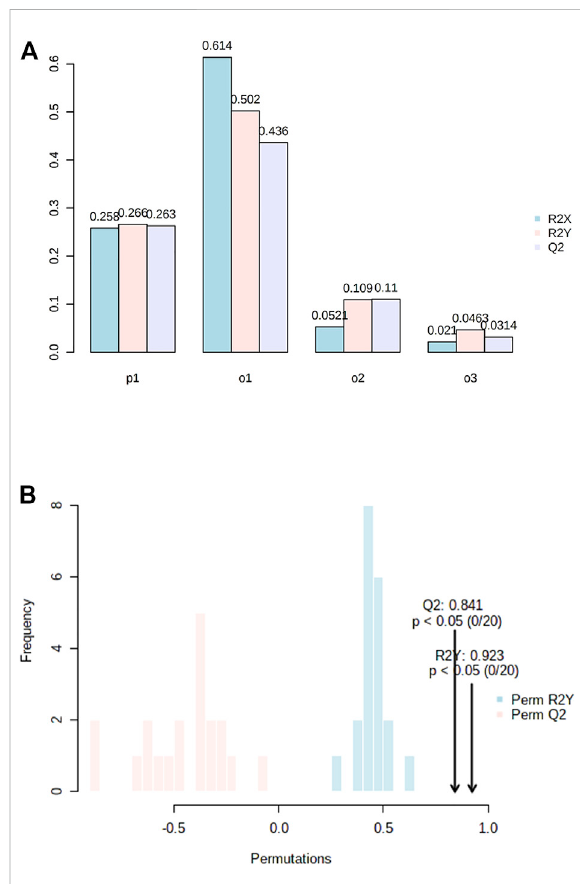
FIGURE 3 (A) Model overview of the OPLS-DA model for the provided dataset. It shows the R2X, R2Y, and Q2 coef fi cients for the groups; (B) Permutation analysis, showing the observed and cross- validated R2Y and Q2 coef fi